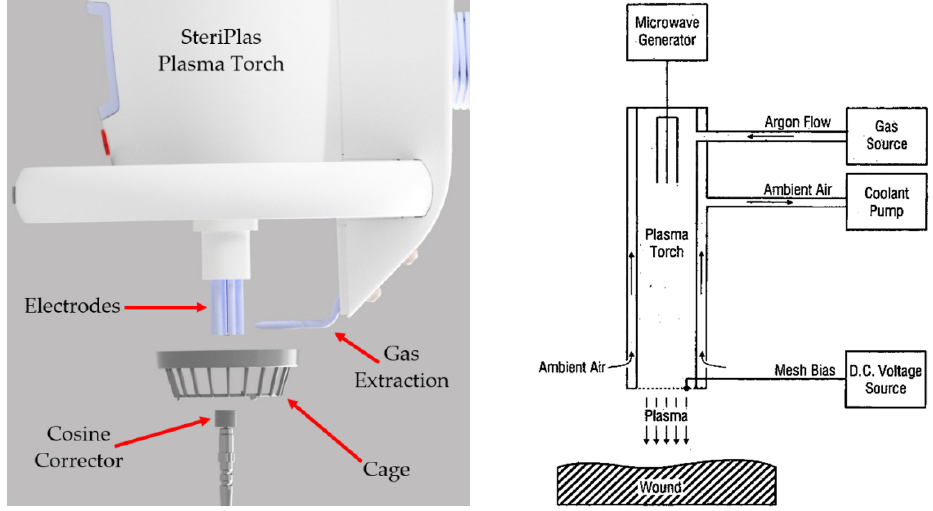
Figure 2. Experimental setup of the spectral irradiance measurement ( left ) and the schematic of the plasma torch ( right ) [15].